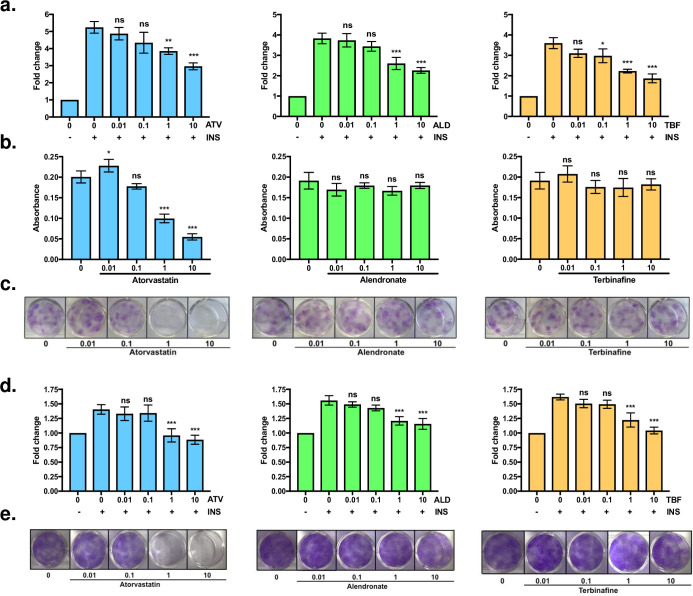
Functional validation of key driver genes.(a) Insulin mediated glucose uptake assay in mature human adipocytes. Fold change values are shown with respect to no insulin (-). Each panel shows the effect of varying concentrations of inhibitor for HMGCR (atorvastatin), FDPS (alendronate) and SQLE (terbinafine). (b) Adipogenic differentiation assay. The effect of different concentrations of the inhibitors over SGBS adipogenesis is measured by absorbance measurement of Oil-O-Red emission at 500nM. (c) Growth assay in human SGBS preadipocytes. Crystal violet staining after 12 days of assay in presence/absence of the inhibitors. (d) Insulin mediated glucose uptake assay in mature human SKMCs. See (a). (e) Growth assay in human SKMCs. See (b). Results represent mean±SD, and statistical significance was evaluated through One way ANOVA *p<0.05, **p<0.01, ***p<0.001 compared to insulin condition without inhibitors (a and d) or basal differentiation (c).